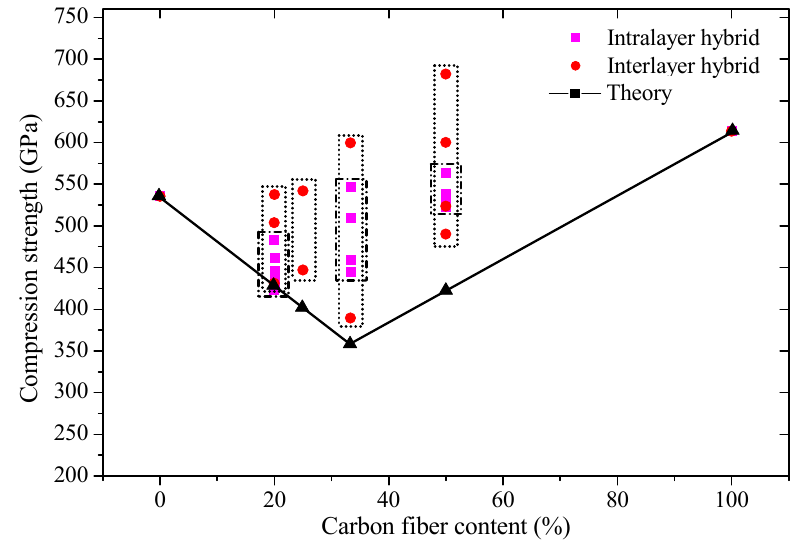
Figure 12. Interlayer and intralayer compression strength obtained by experiment and ROM.